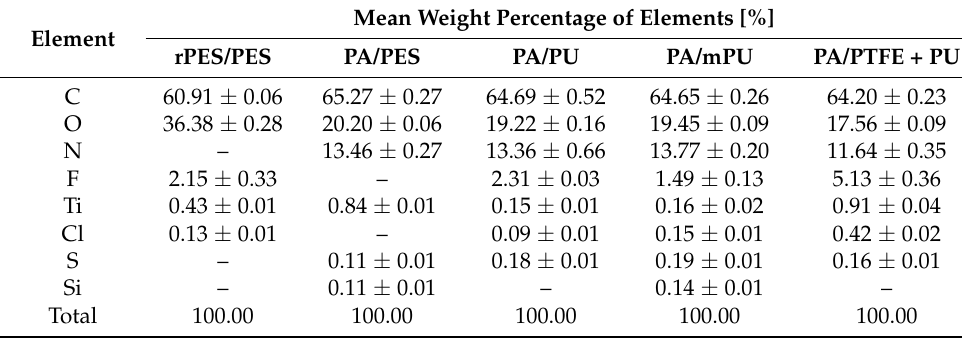
Table 6. Results of EDS analysis of fabric surfaces.